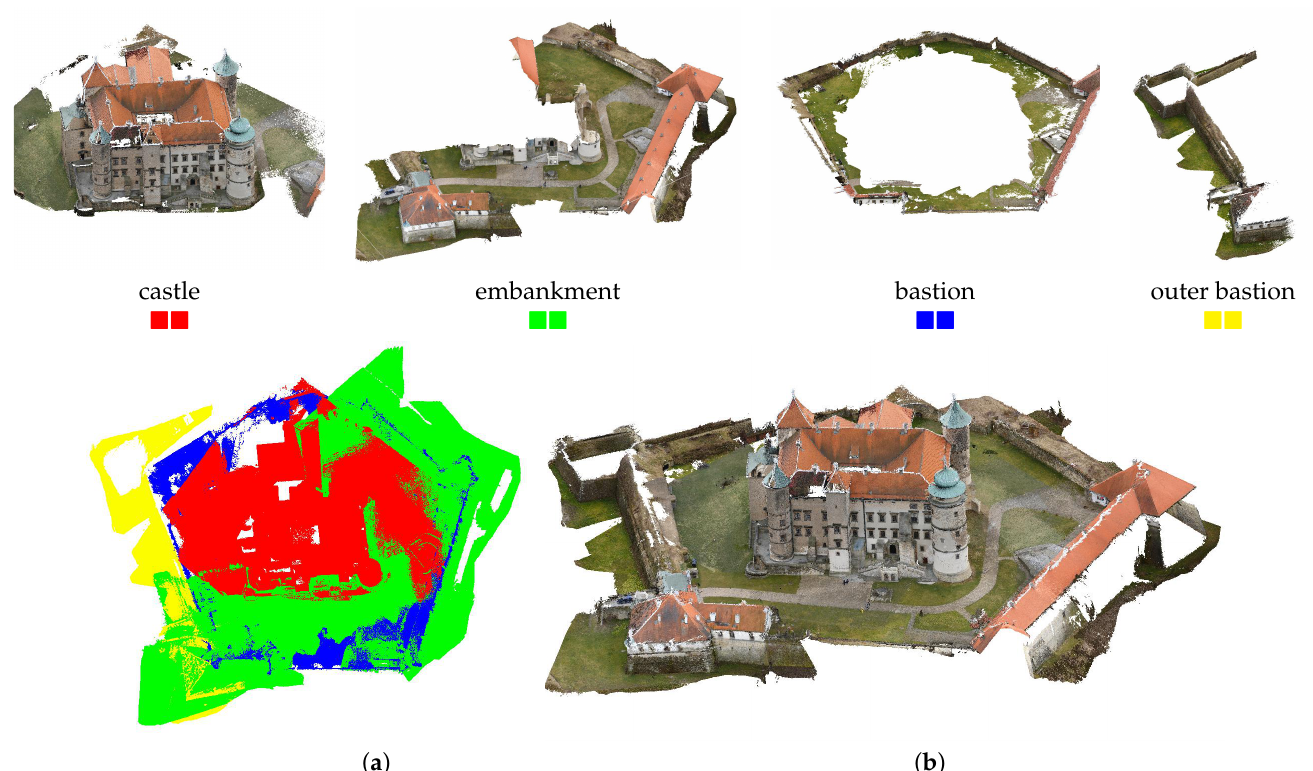
Figure 13. Linking the castle shell to the bastions: mapping the segments ( a ), the resultant point cloud ( b ).